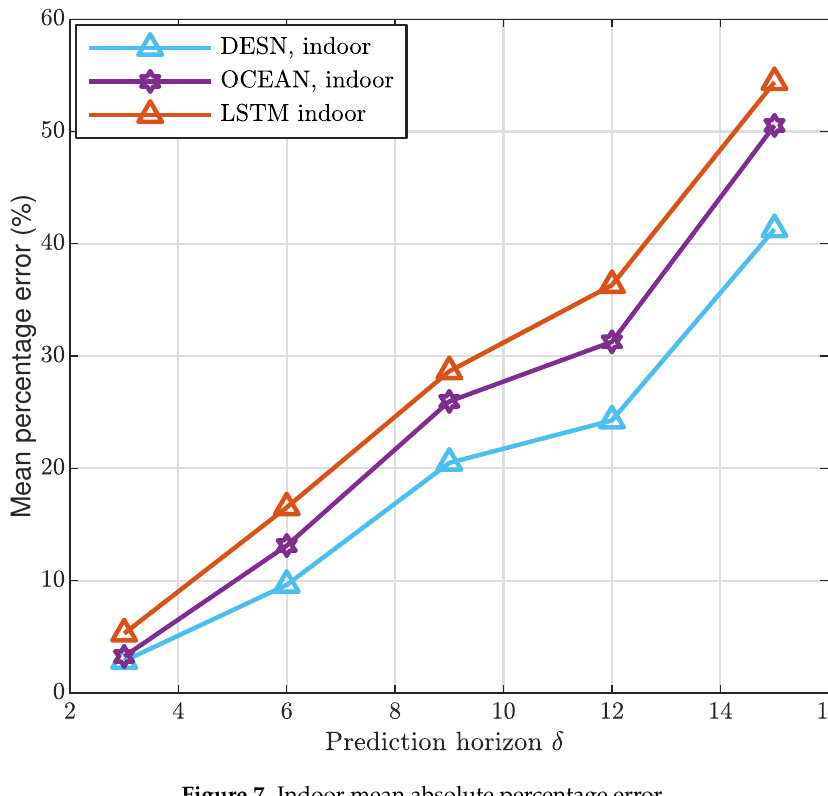
Figure 7. Indoor mean absolute percentage error.